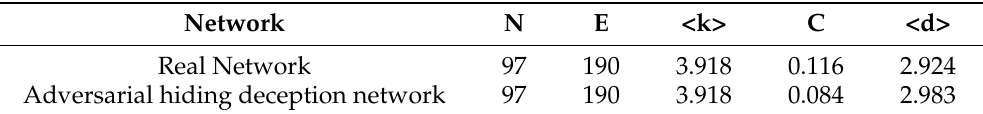
Table 2. Basic network topology characteristics include Network size N, edge number E, average degree <k>, average path length <d>, clustering coefficient C.